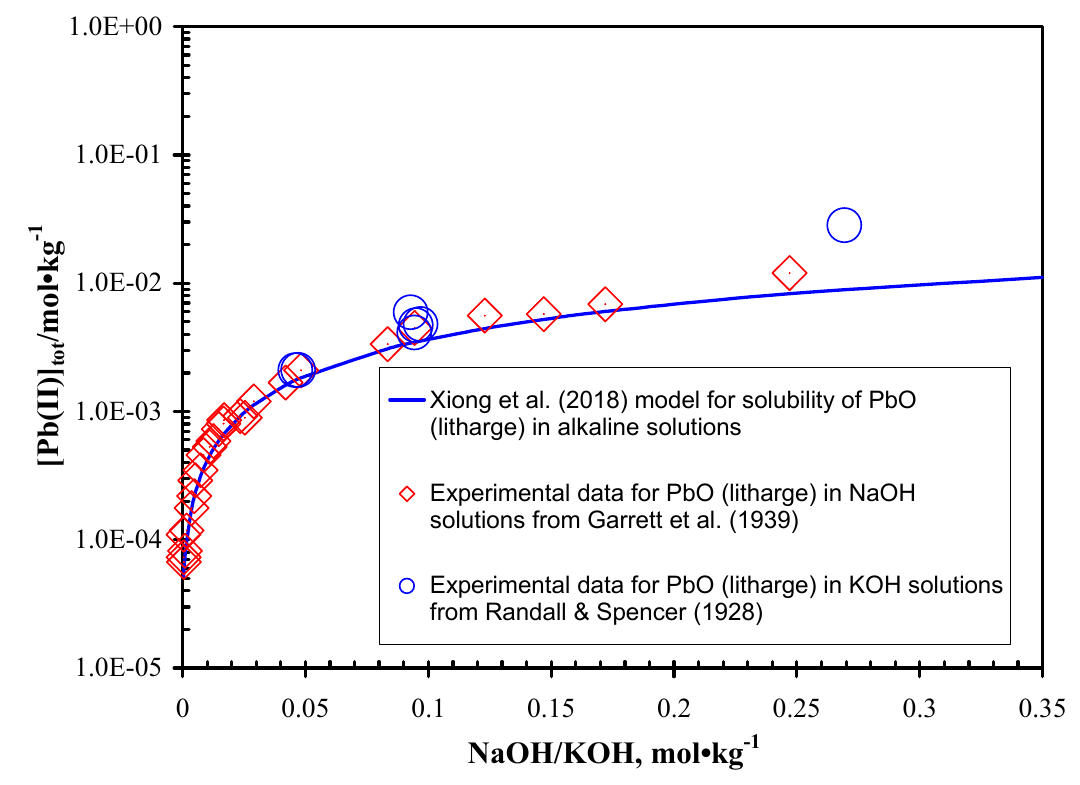
Figure 10. Solubilities of lead monoxide (PbO, litharge) as a function of hydroxyl concentrations in dilute and moderate concentration ranges at 25 °C, applicable to desulphurization and leaching of lead pastes with alkaline solutions. The experimental data are from Randall and Spencer [39] and Garrett et al. [40]. The calculated solubilities are based on the model of Xiong et al. [15].